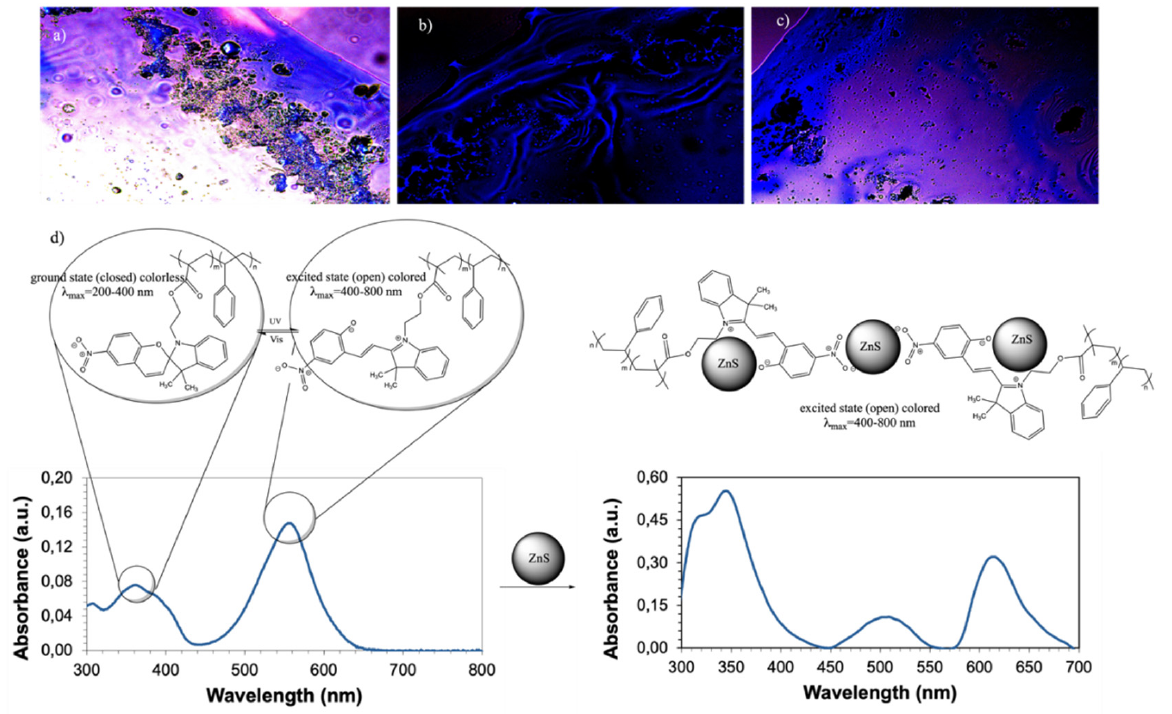
Figure 8. Optical fluorescence images (in CS 2 ) of the photoactive polymer- SP prepared at 3 g L − 1 ( a ) without ultraviolet irradiation under natural light; ( b ) with ultraviolet irradiation under fluorescence; ( c ) with ZnS (NPs) 5 wt.% under ultraviolet irradiation at 365 nm and under fluorescence d) Ultraviolet–visible spectra of an acetonitrile solution of PS- b -PMMA- SP after irradiated and PS- b -PMMA- SP -ZnS NPs at 5 wt.%, after irradiated for 10 min with an ultraviolet